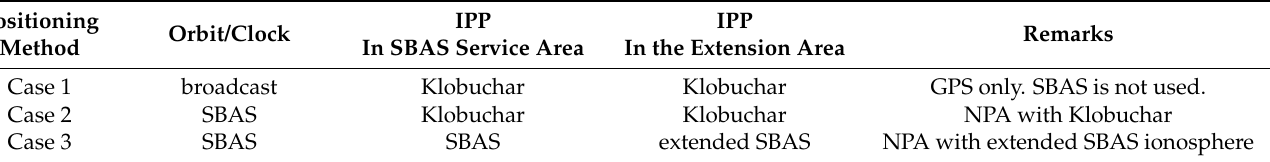
Table 1. List of experimental cases with different types of space-based augmentation system (SBAS) corrections.